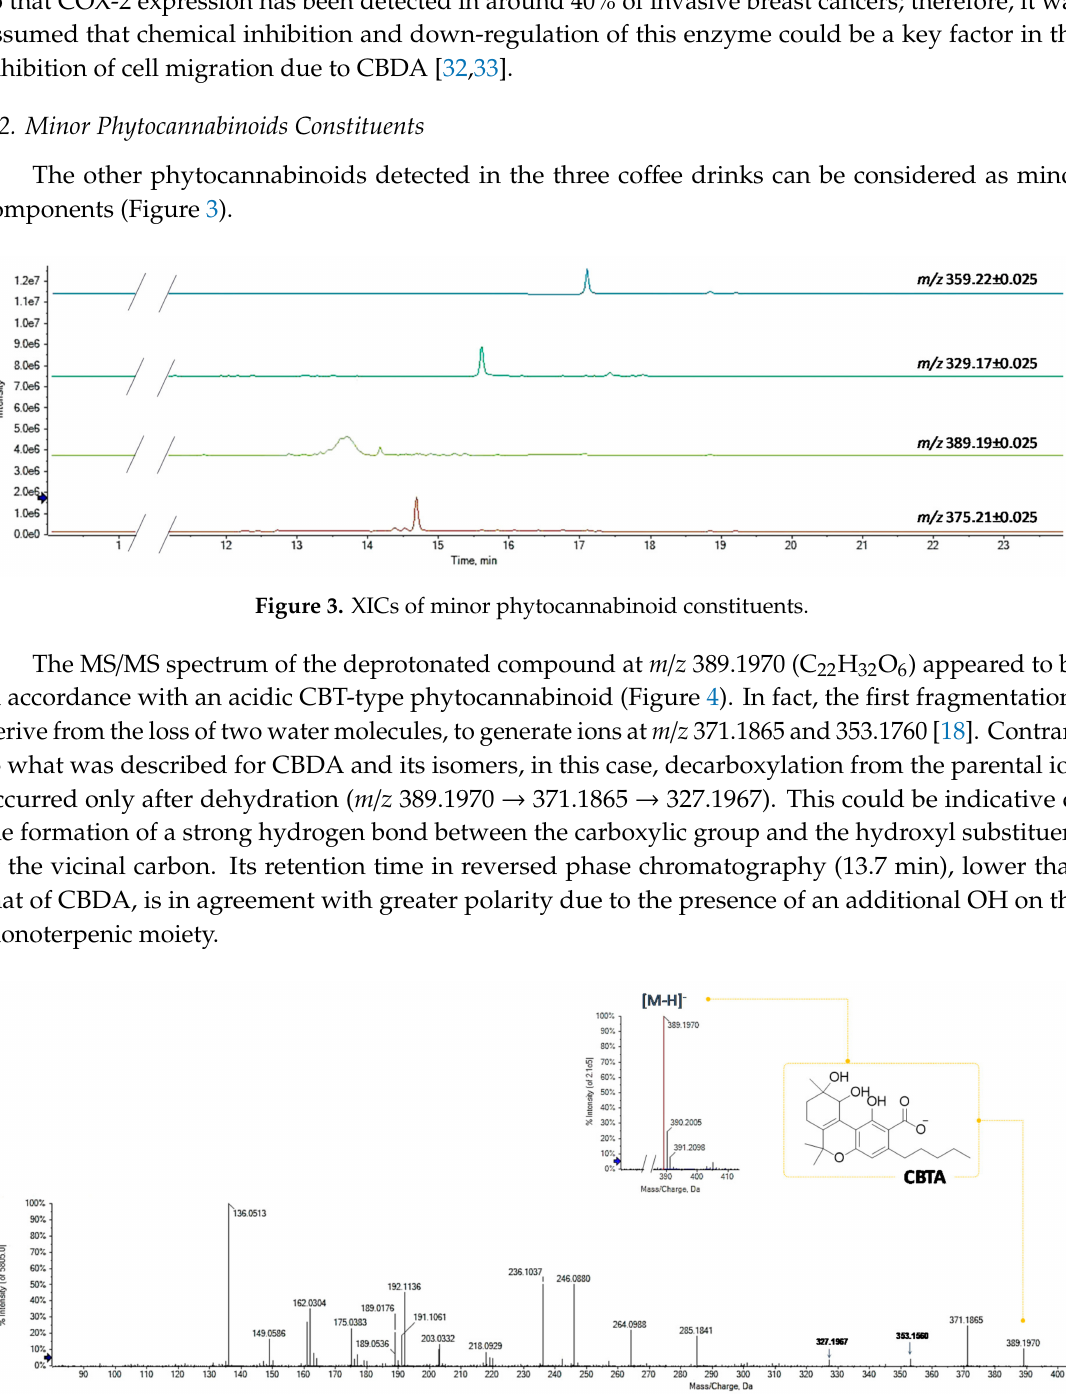
Figure 4. HR-MS and MS / MS of the phytocannabinoid at m / z